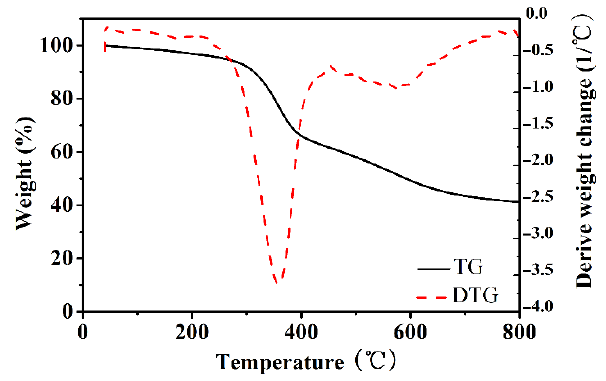
Figure 1. TGA and DTG curves of PRF-50C-85% under nitrogen flow.